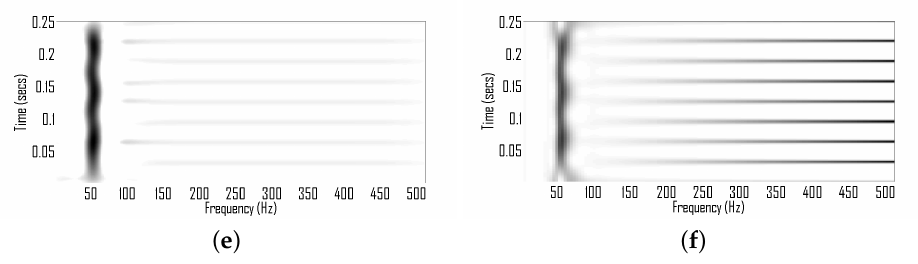
Figure 2. TF plots of the synthetic signal, given by Equation (15), ( a ) Spectrogram (hamming window of length 45); ( b ) reassigned Spectrogram; ( c ) MBD ( β = 0.1 and lag window of length 64); ( d ) Gabor Wigner transform (Gabor transform of window length 45 is used); ( e ) the adaptive TFD ( a = 3 and b = 8); and ( f ) the S-transform.